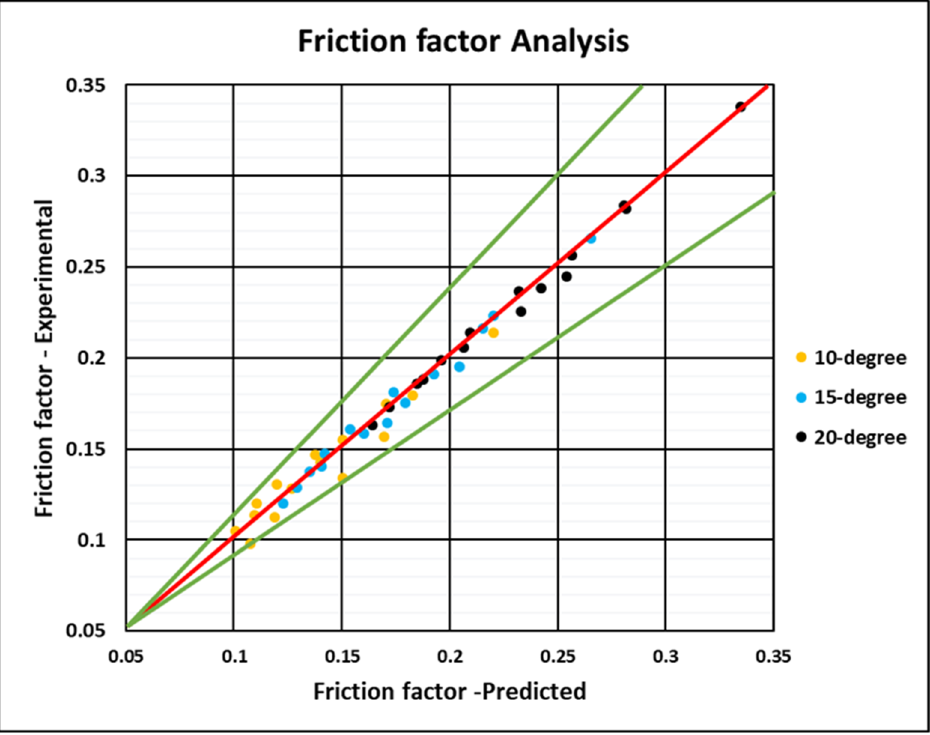
Figure 18. Observed data vs. anticipated data of f.